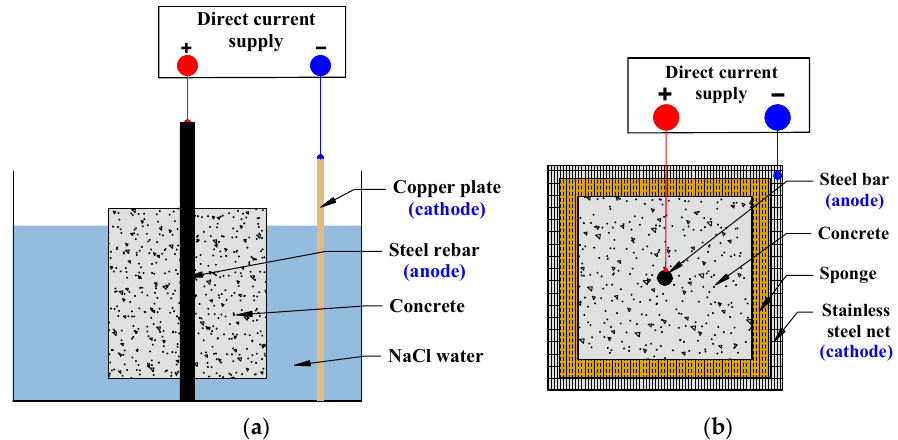
Figure 6. Accelerated electrical method: ( a ) Immersed specimen; ( b ) Wrapped specimen.